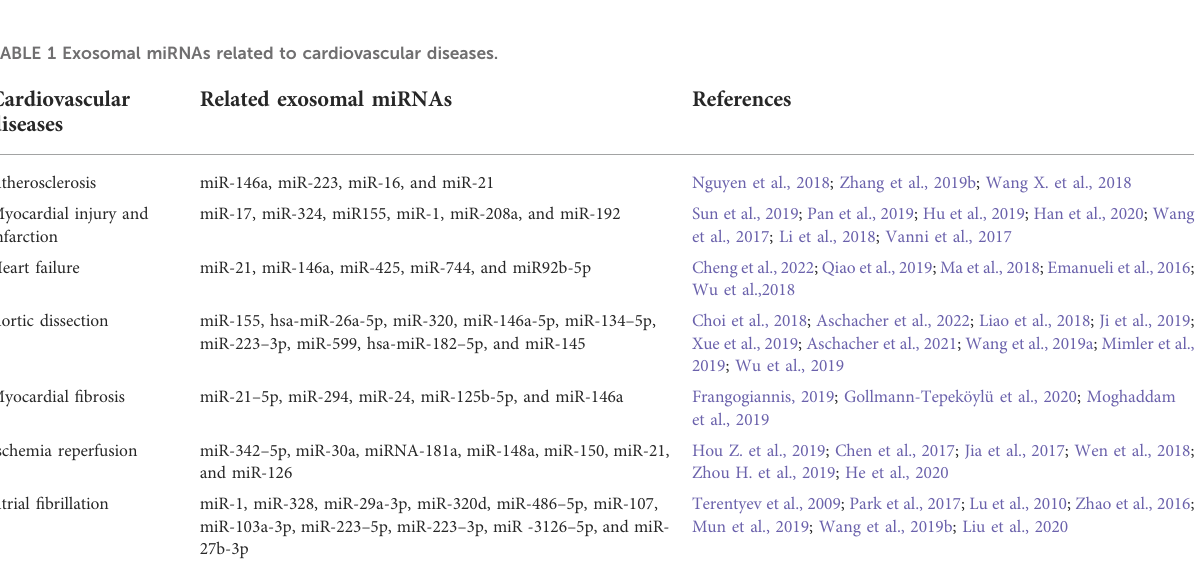
TABLE 1 Exosomal miRNAs related to cardiovascular